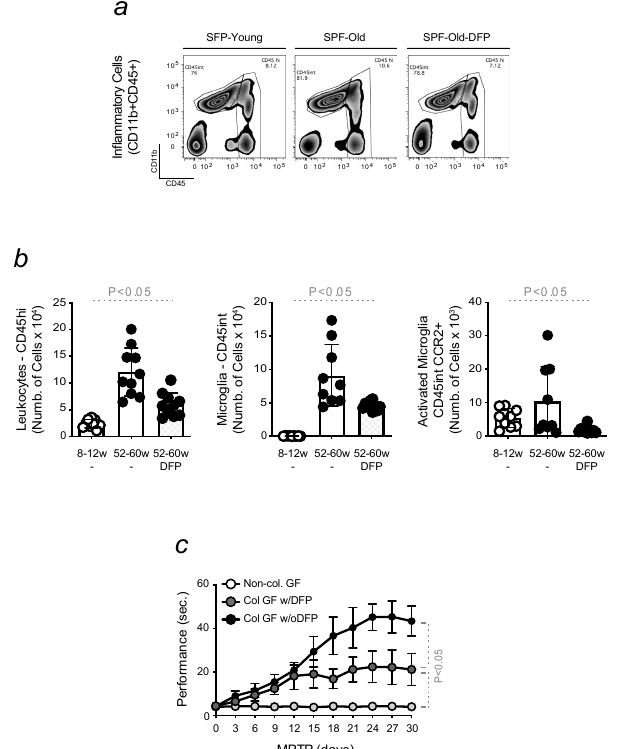
Figure 7. Oral administration of the Fe chelator DFP protects mice against age-related dysbiosis and the development of PD. Gating strategy of ( a ) freshly isolated infiltrated leukocytes (CD45hi) and microglia (CD45int), within contour plots, from the brain of young vs. old mice, treated or not with DFP. ( b ) Total number of cells in ( a ) and microglia activation. ( b ) The results were expressed as mean ± SD ( n = 4–11 mice per group). Statistical analysis was performed by applying non-parametric Mann–Whitney Test. ( c ) Motor performance of GF mice, colonized or not (Ctrl) with stool samples collected from conventional old mice, treated or not with DFP (10 mg/kg, i.p. for 15 days). The results are expressed as mean ± SD ( n = 7–10 mice per group). Statistical analysis was performed by applying the one-way ANOVA